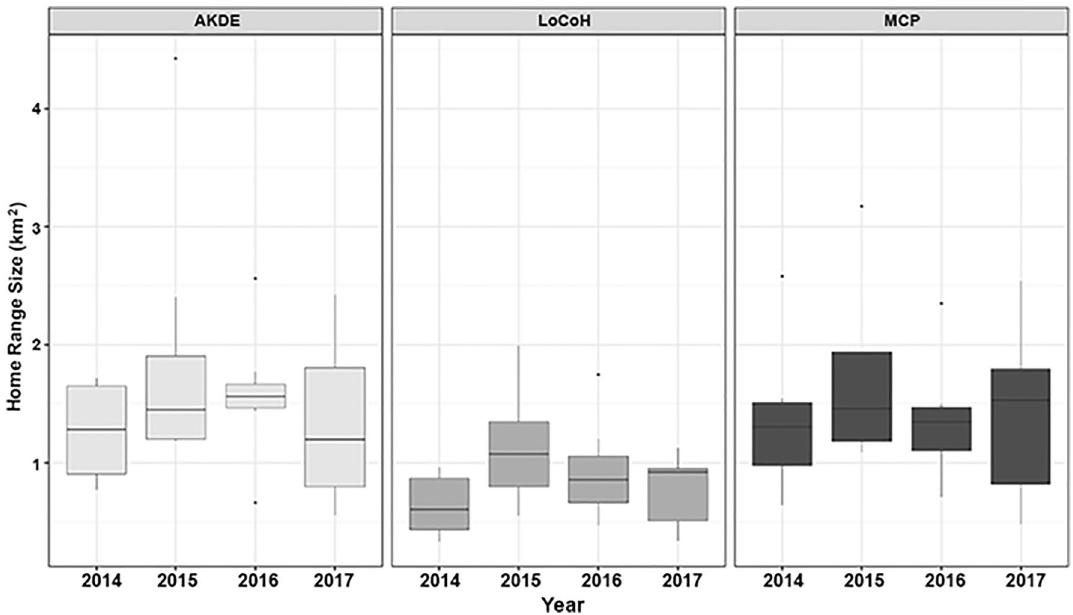
Figure 2. Comparison of home range sizes for each year of the study using three different home range size estimation methods: 95% Home Range Estimators (autocorrelated kernel density estimates (AKDE), local convex hulls (LoCoH) and minimum convex polygons (MCP), measured in square kilometres [km 2 ]). The median is shown as a black horizontal line, with upper and lower quartiles (mean point between maximum/ minimum data points and the median) at the top/bottom of the bar. Whiskers (vertical black lines) denote lower and upper 25% of data values. Black points denote outliers (data points 1.5 times lower/higher than the interquartile